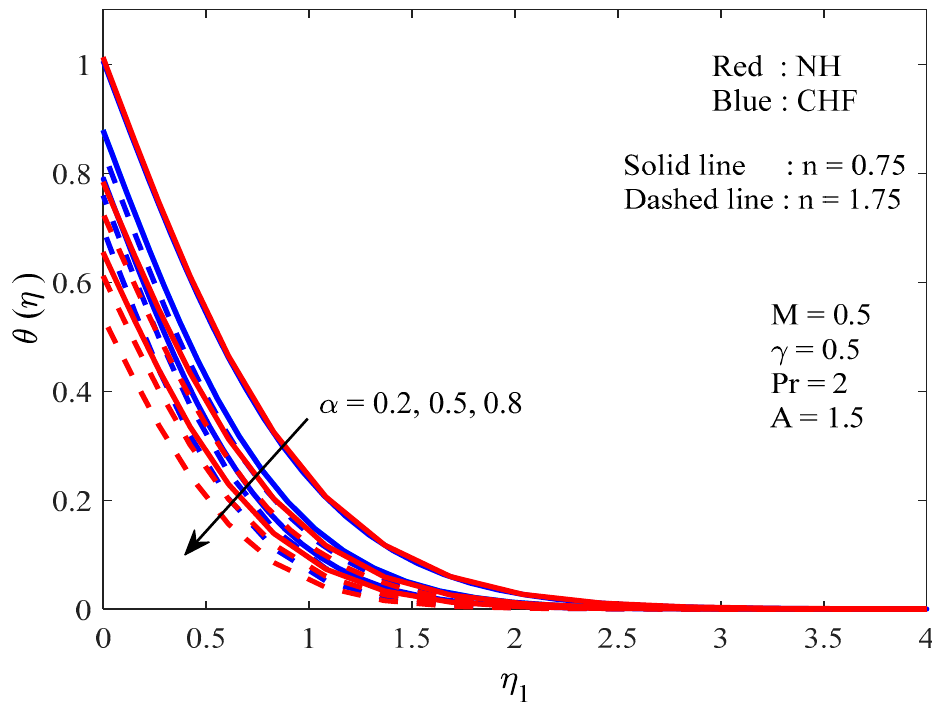
Figure 5. The temperature distribution profile with the influence of